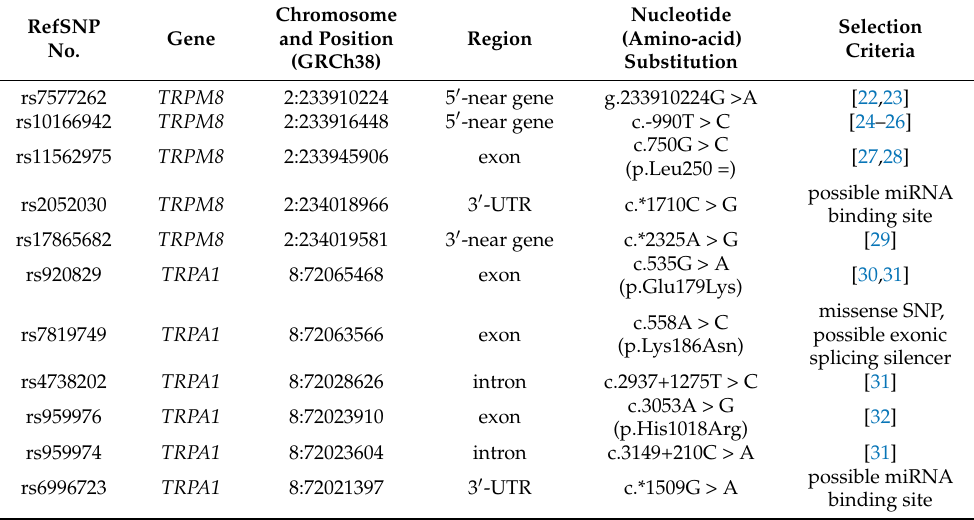
Table 1. Brief characteristics of the studied